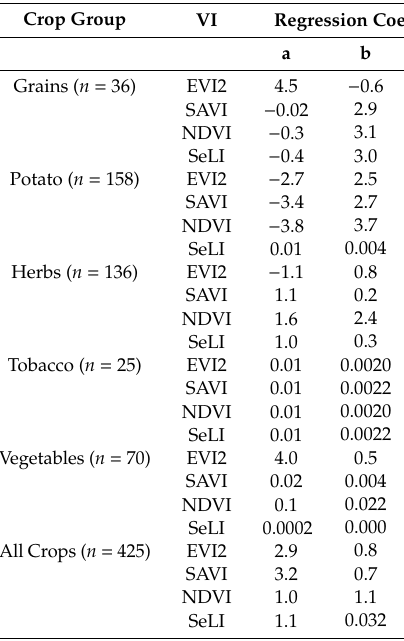
Table 6. Statistics obtained using regression equations of the form y = (a × VI + b) × (1 + c × exp (d × VI)) for each of the studied index, for the studied crop